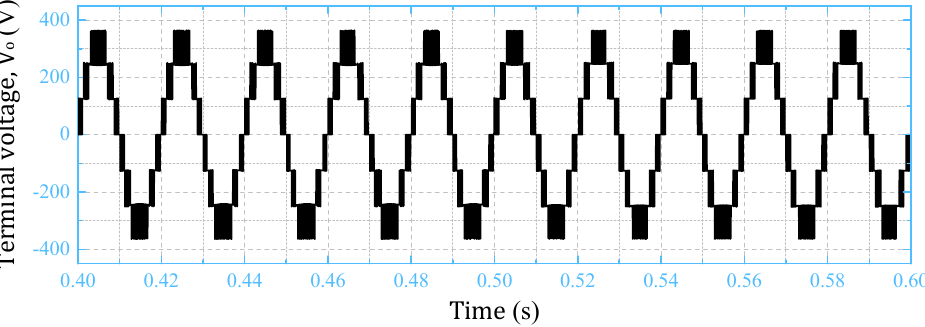
Figure 8. Multi-Level inverter output voltage.